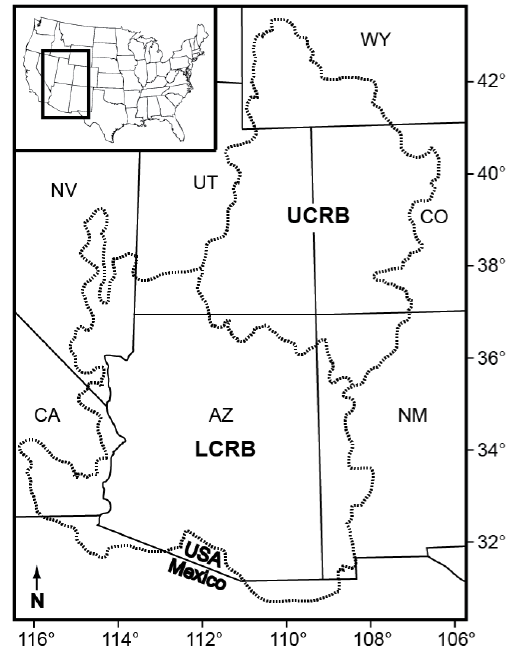
Figure 1. Map showing the locations of the Upper and Lower Col- orado River basins (UCRB and LCRB, respectively) outlined by the dotted